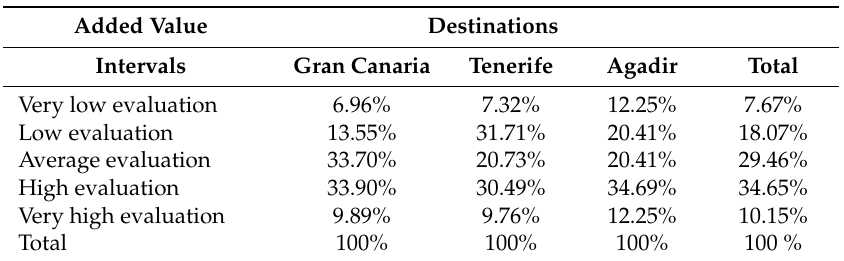
Table 9. Comparative analysis of the added value